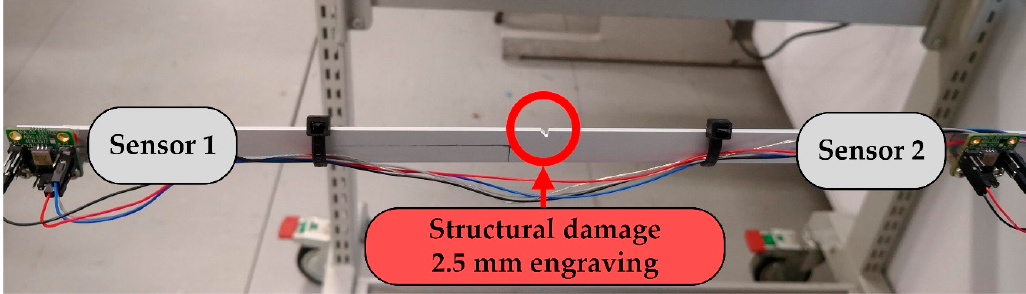
Figure 5. Engraved aluminum bar anchored in the bench vice for the damage detection test.